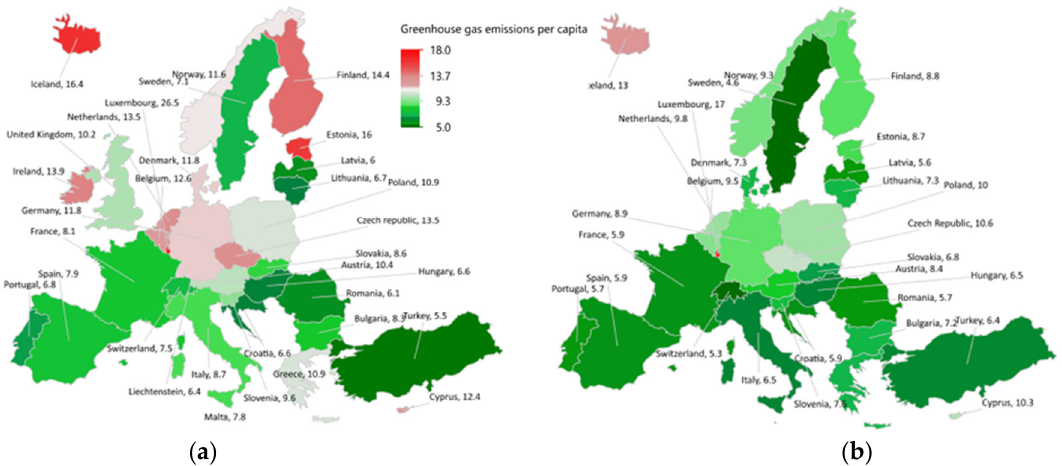
Figure 1. Cartographid representation of greenhouse gas emissions per capita in EU member states: ( a ) in 2010 and ( b ) 2020. Source: own processing according to [22], processing in JMP. Note: The legend applies to both ( a , b ).